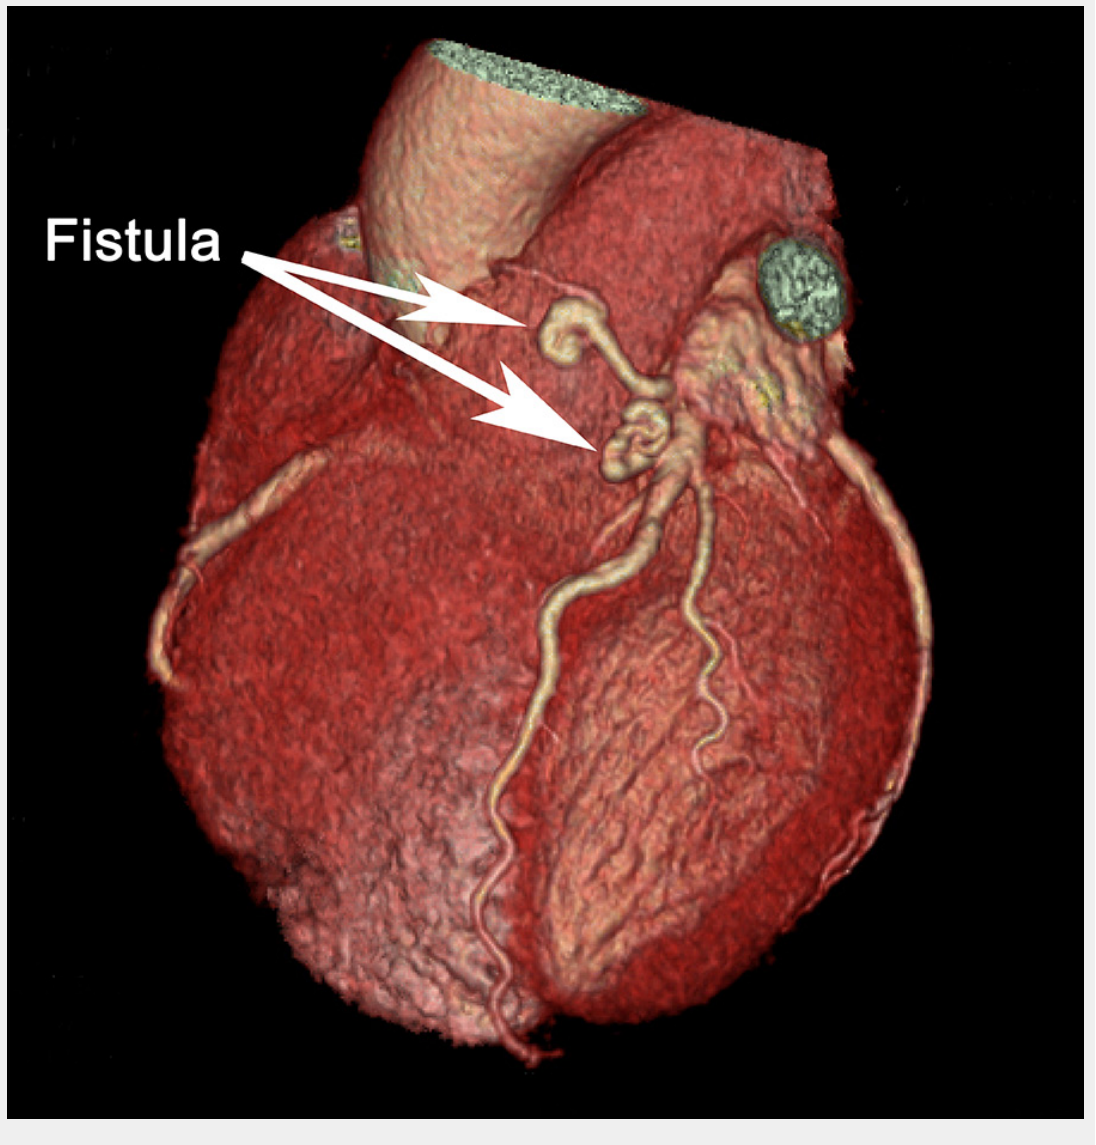
Figure 4 CCTA of a 64-year-old patient with atypical angina referred for exclusion of CAD shows no relevant CAD but a coronary artery fistula originating from the LAD and terminating in the pulmonary artery, potentially causing his symptoms. CAD = coronary artery disease; CCTA = coronary computed tomography angiography; LAD = left anterior descending